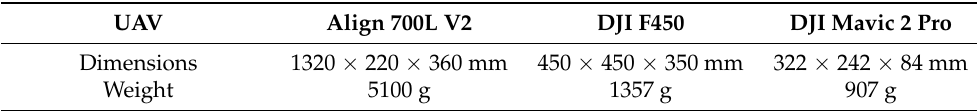
Table 2. Properties of the three UAV obstacle